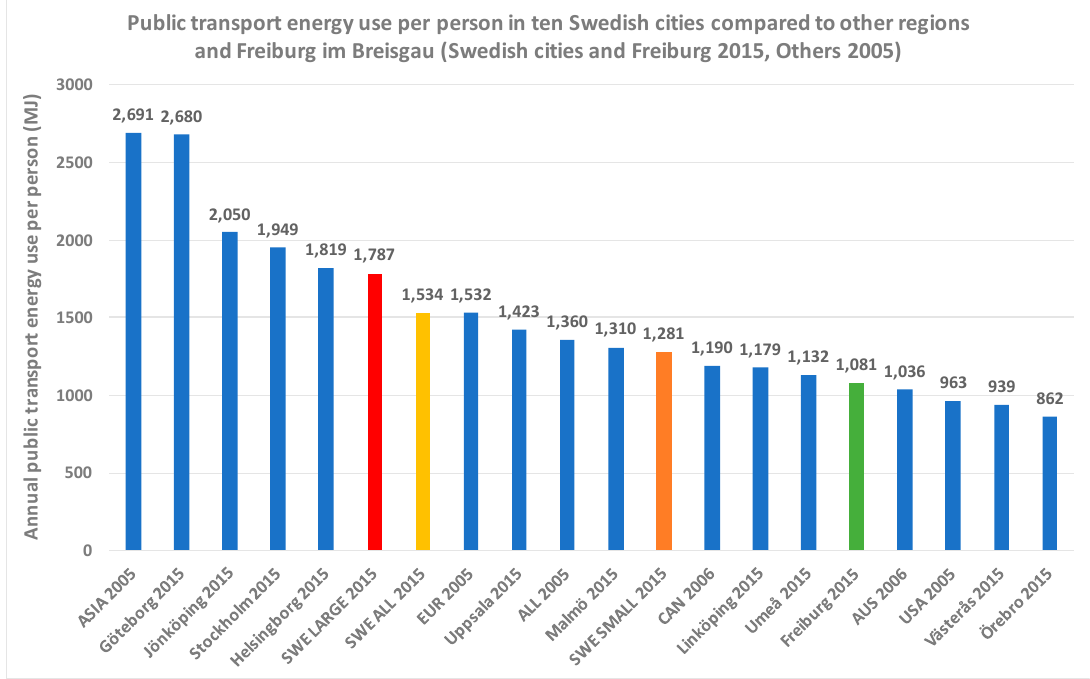
Figure 2. Annual public transport energy use per person in ten Swedish cities (2015); Freiburg (2015); and American, Australian, Canadian, European and Asian cities (2005–2006).